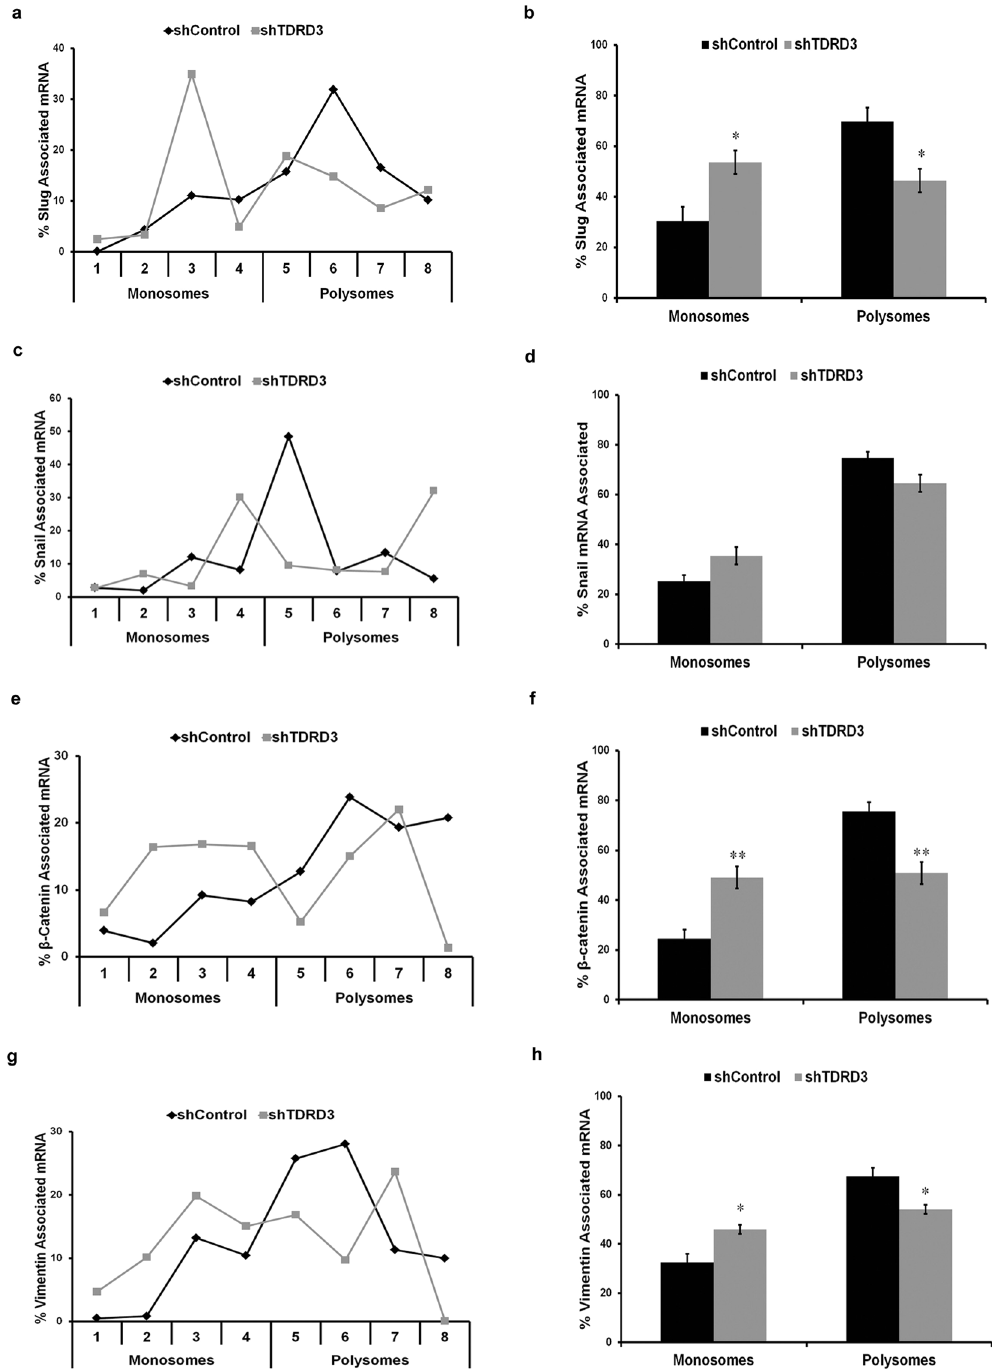
Figure 6. TDRD3 Regulates Translation in Breast Cancer Cells. Cytoplasmic extracts from MDA MB 231 cells infected with shControl or shTDRD3 for 96 h were subjected to fractionation on a 10–45% sucrose gradient. RNA was isolated from each fraction and RT-qPCR analysis was performed determining ( a,b ) Slug, ( c,d ) Snail, ( e,f ) β -catenin, and ( g,h ) Vimentin mRNA distribution. The line graph is a representative result of one independent trial, while the bar graph represents the pooled mRNA association from each monosome and polysome fraction. Significance (n = 4, * p < 0.05, ** p < 0.01) was determined using a two-tailed t